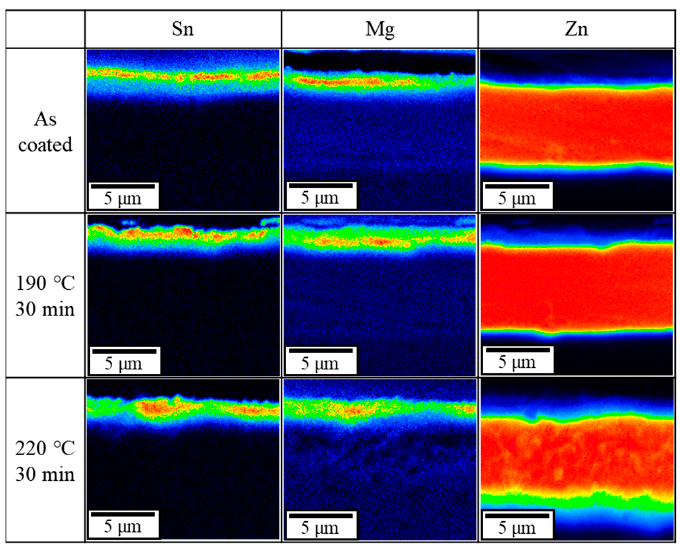
Figure 4. EPMA mapping images of Sn/Mg films as a parameter of heat treatment.